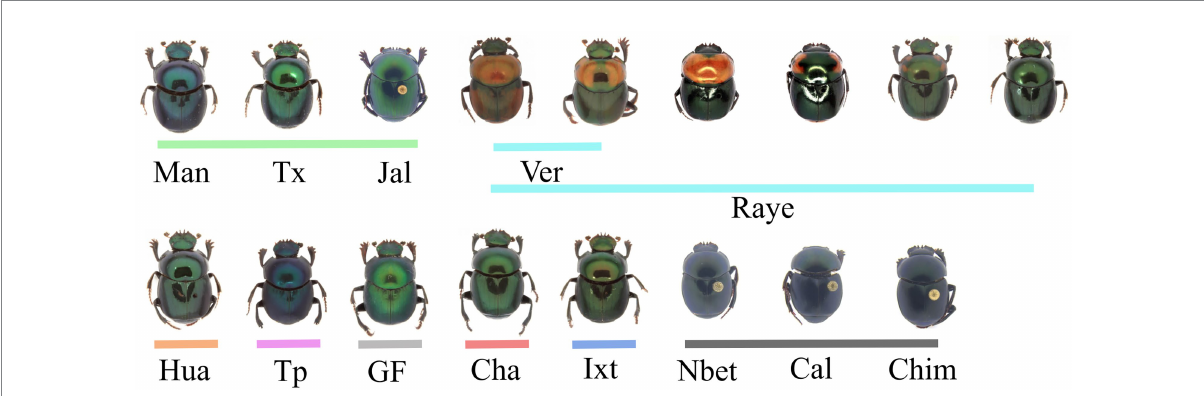
FIGURE 9 Morphological variation of color pattern in Canthon cyanellus populations. Colored lines correspond to the clade color shown in the Bayesian tree in Figure 3, (Nolasco-Soto et al., 2020). The genealogy was estimated from Bayesian inference (BI) analysis using the software MrBayes v.3.2.6 (Ronquist et al., 2012) available in the CIPRES portal (Miller et al., 2010).